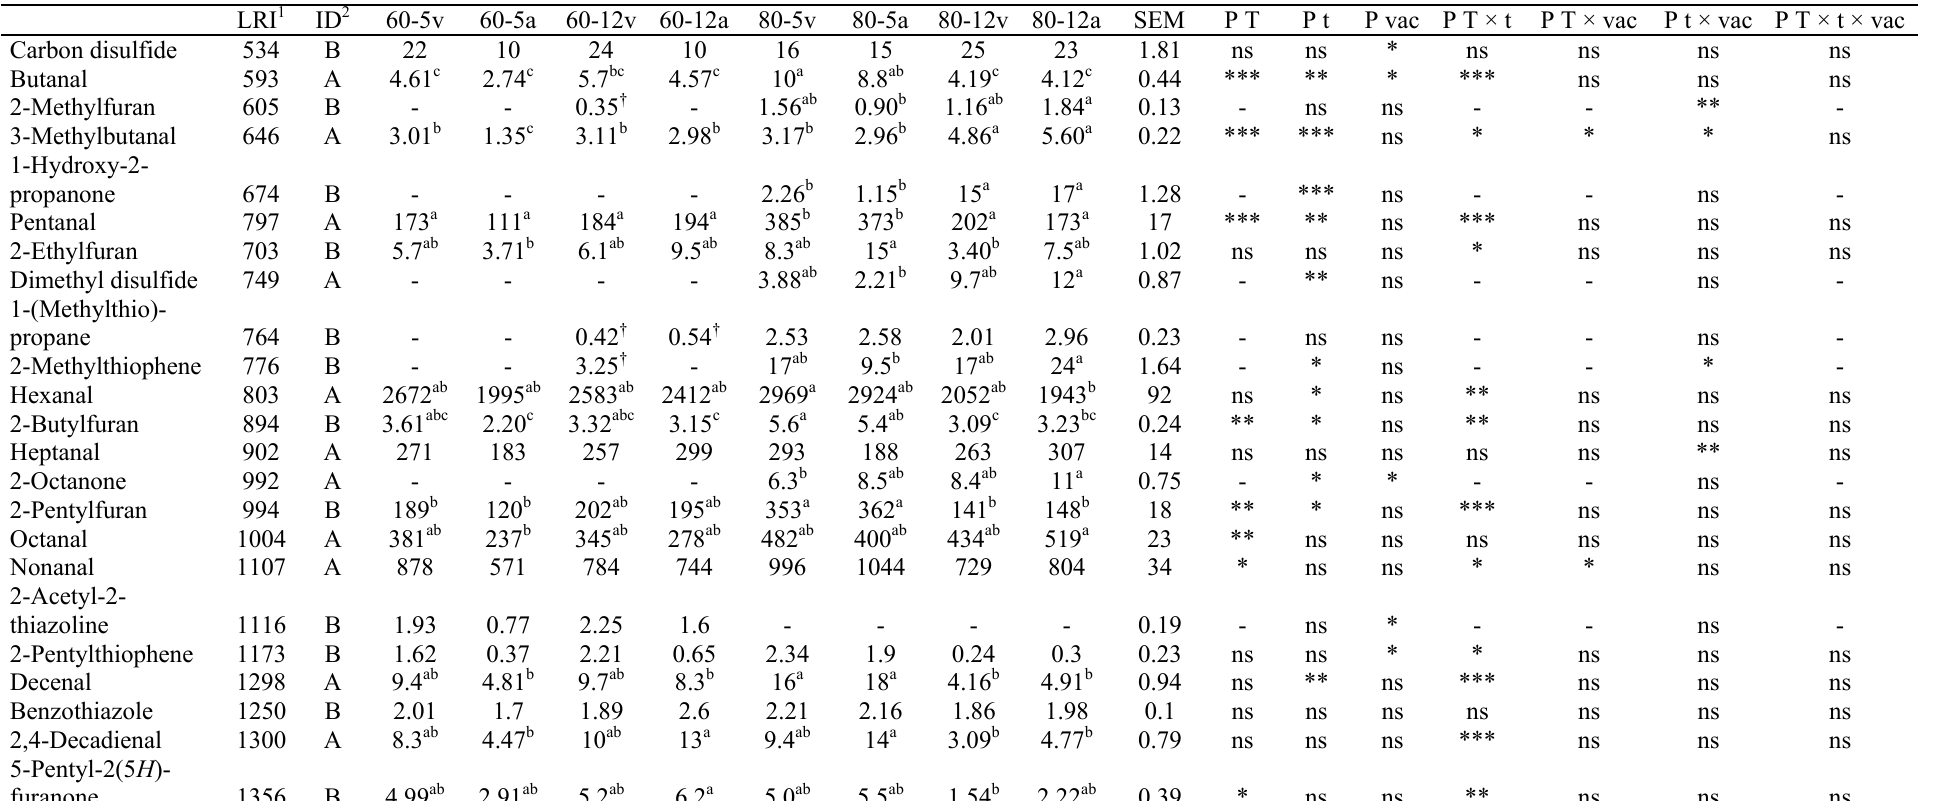
Table 1. Selected volatile compounds (in area units × 10 − 5 ) in pork cheeks cooked at different combinations of temperature (60 vs. 80 °C), time (5 h vs. 12 h) and vacuum (vacuum packaged vs.